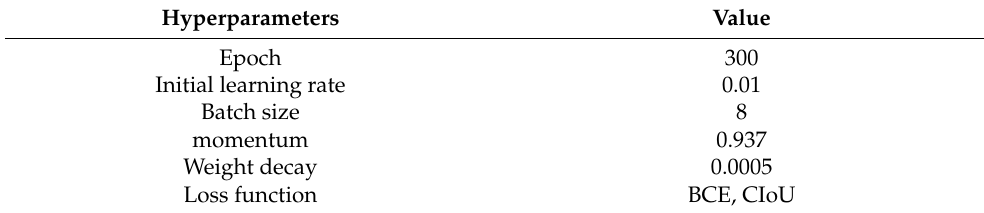
Table 4. The hyperparameters in the training process.